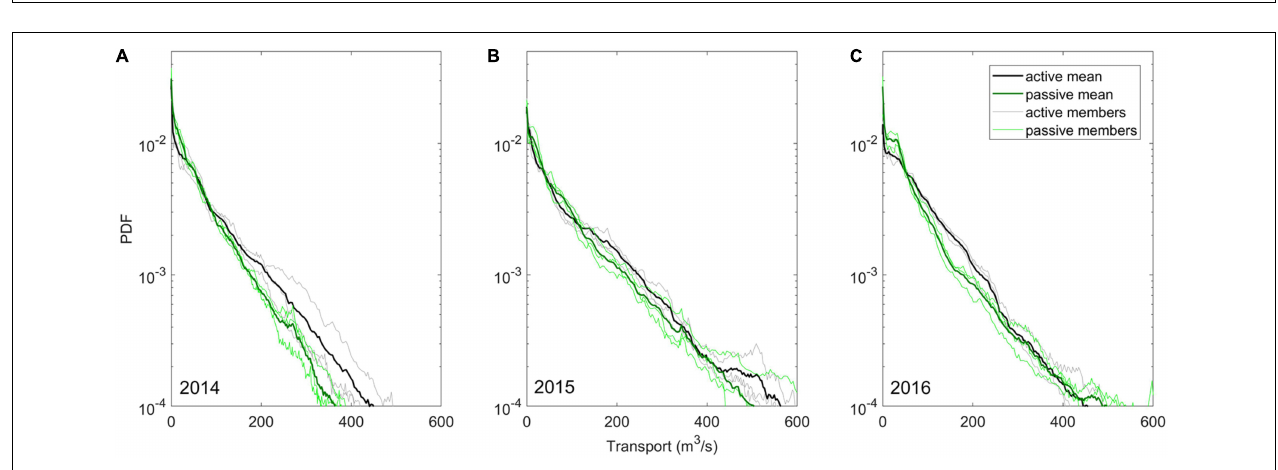
FIGURE 9 | Monthly averaged freshwater zonal (a,d,g) and meridional (b,e,h) transport, as well as the transport vector (c,f,i) integrated between 100 and 200 m in April, August, and December 2015. The fields are obtained from the first member of the SP active ensemble. Units: m 3 /s.